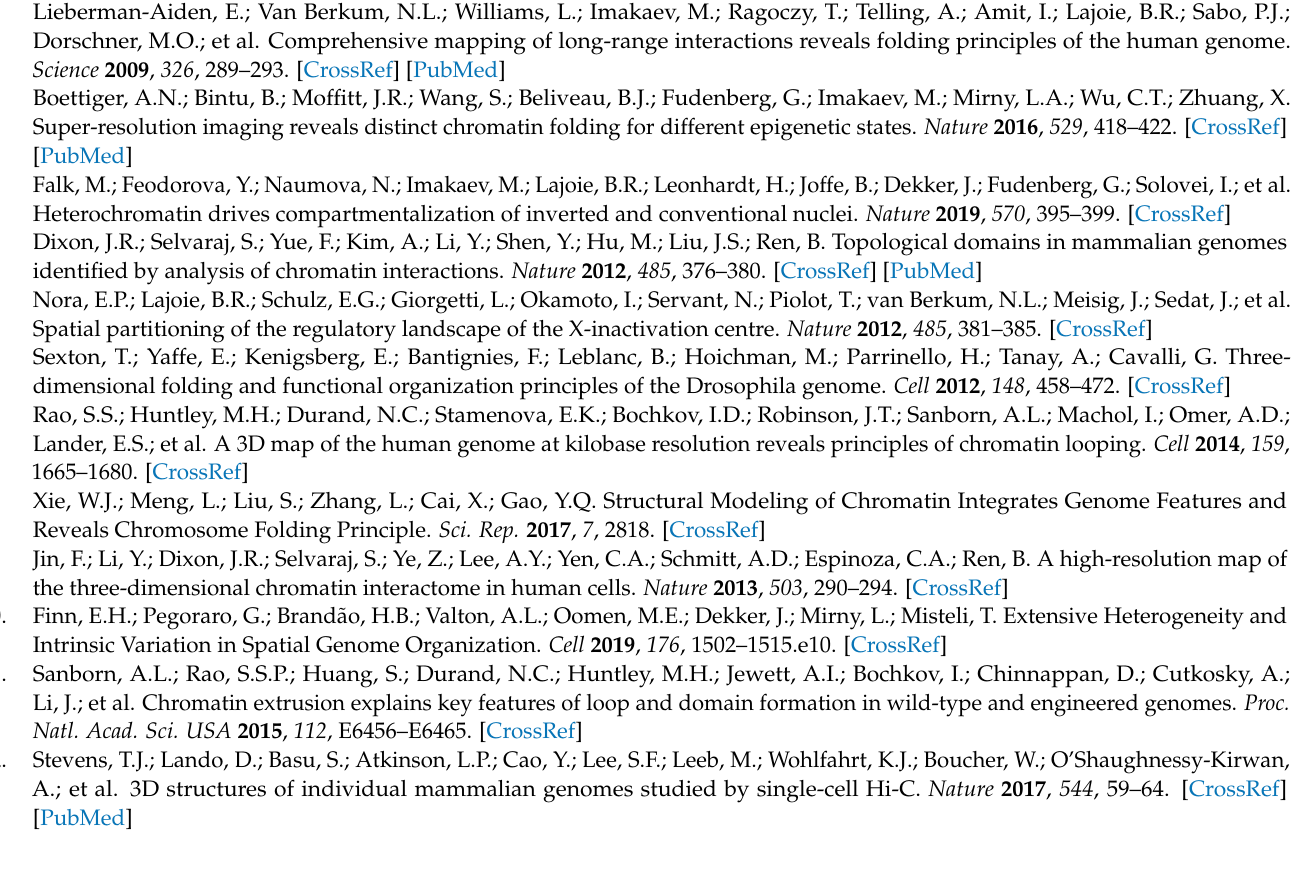
Figure A3. FF and PP contact probability ( P ) as a function of sequential distance obtained from the 1-Chr system considering different ε PP values.